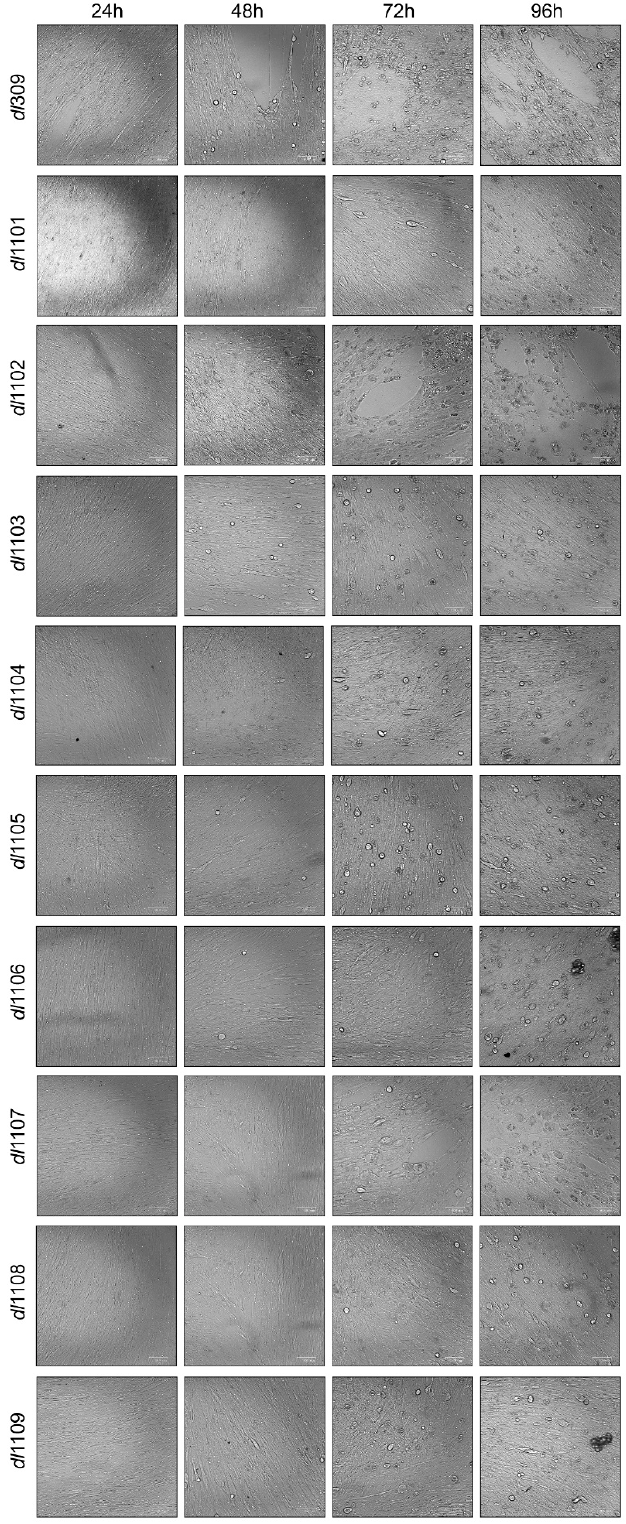
Figure 2. Cytopathic e ff ect in exon 1 E1A harboring HAdV-infected WI-38 cells. WI-38 cells were grown until confluence at which point medium was replaced and cells were incubated for 72 h before infection with the indicated viruses at a MOI of 100. At the indicated time points cells were imaged in the bright field using the BioRad ZOE cell